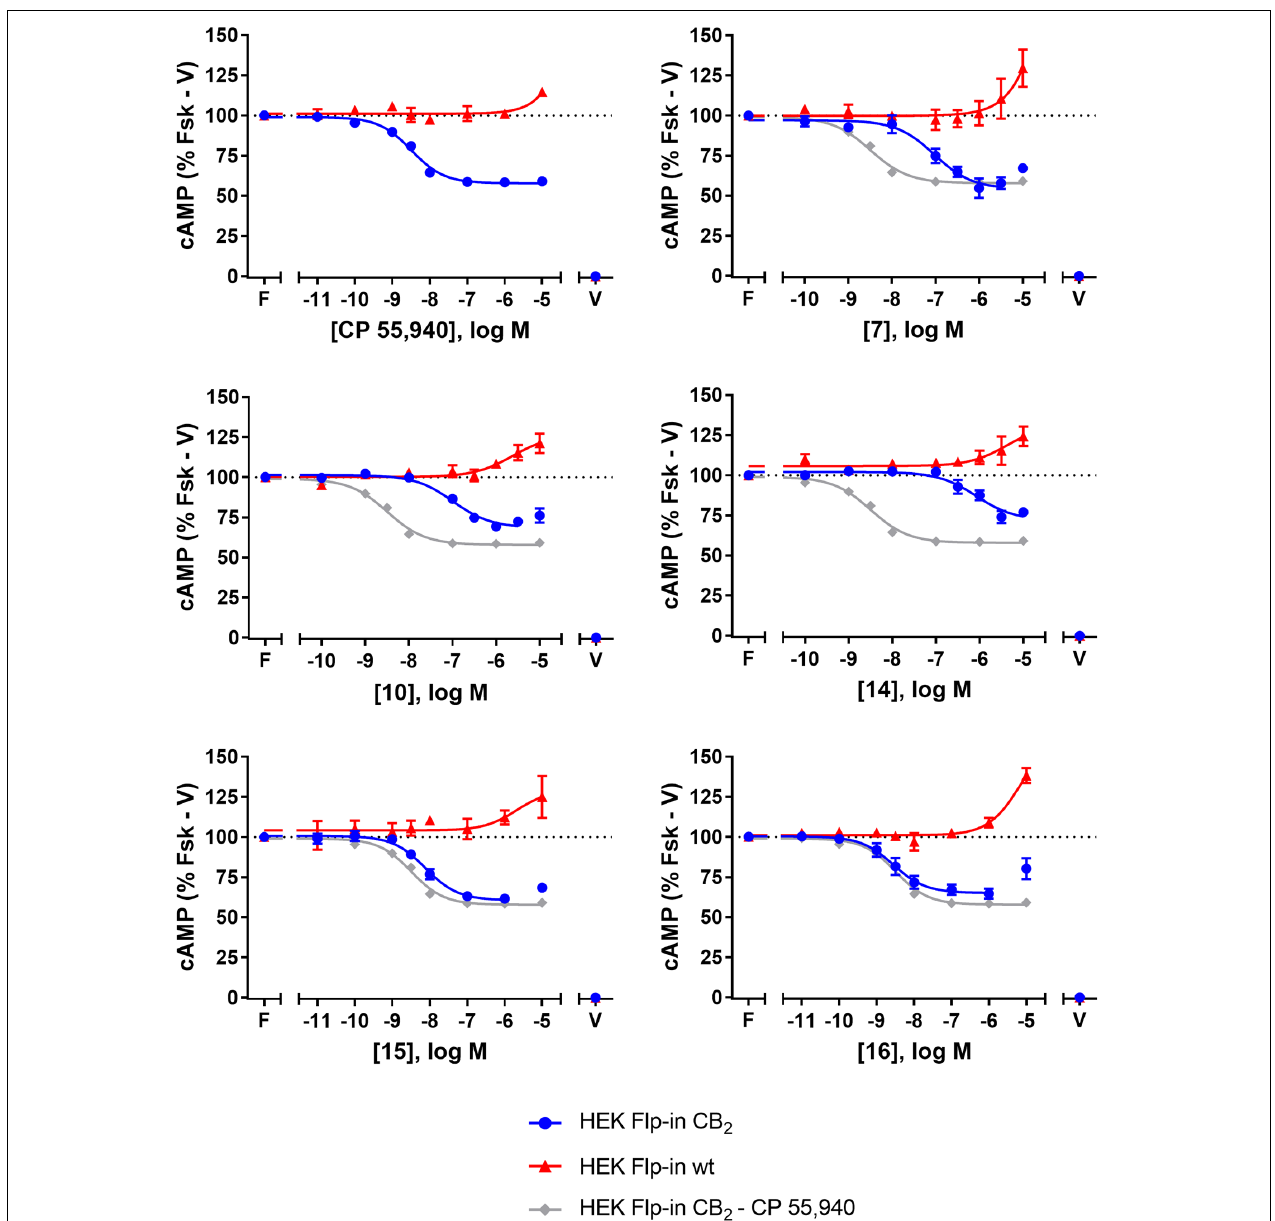
FIGURE 2 | cAMP signalling in HEK Flp-in hCB 2 and HEK Flp-in wt cells in response to CP 55,940 and 2,4,6-trisubstituted 1,3,5-triazines. Concentration-response curves for modulation of cAMP concentration in HEK Flp-in hCB 2 and HEK Flp-in wt cells (showing both hCB 2 - and non-hCB 2 -mediated effects) on stimulation with 5 µ M forskolin and CP 55,940 or test compounds (other than 13 ). Concentration-response curves were generated by plotting measurements at 5 min post-drug addition. These data were then normalised to vehicle-treated (V; 0%) and forskolin alone (F, Fsk; 100%). Data are presented as mean ± SEM from three independent